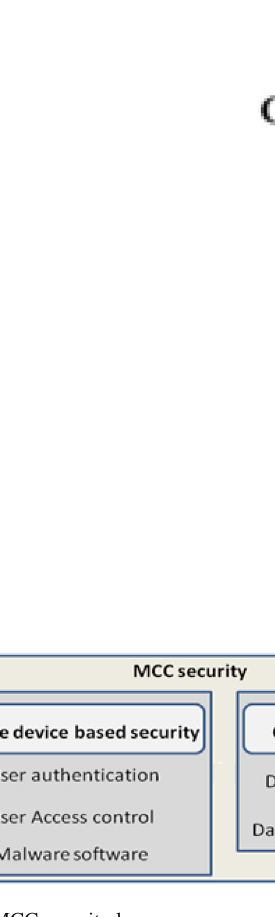
Fig. 9 MCC security